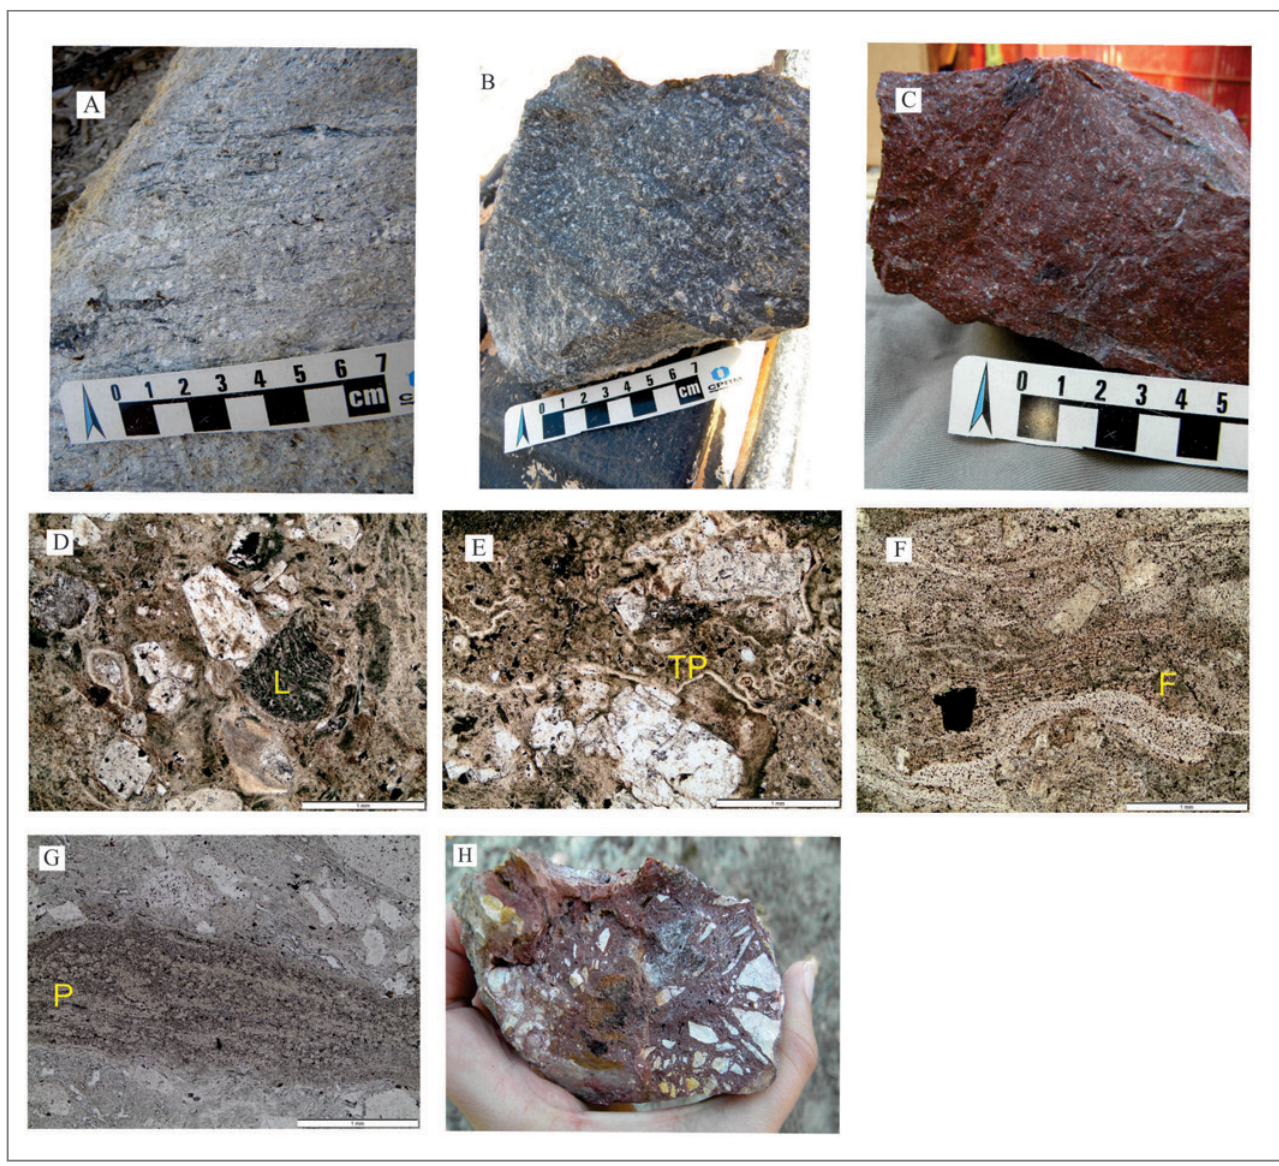
Figure 8 - Mesoscopic and microscopic aspects of rocks of the magnetic pyroclastic facies of the Vila Riozinho Formation. A) Ignimbrite outcrop with flow structures and stretched pumices; B) Gray ignimbrite sample with fine porphyritic texture; C) Ignimbrite with fine porphyritic texture and matrix with hematite alteration; D) Ignimbrite photomicrograph showing matrix flow between phenocrysts and lithic fragments (L); E)